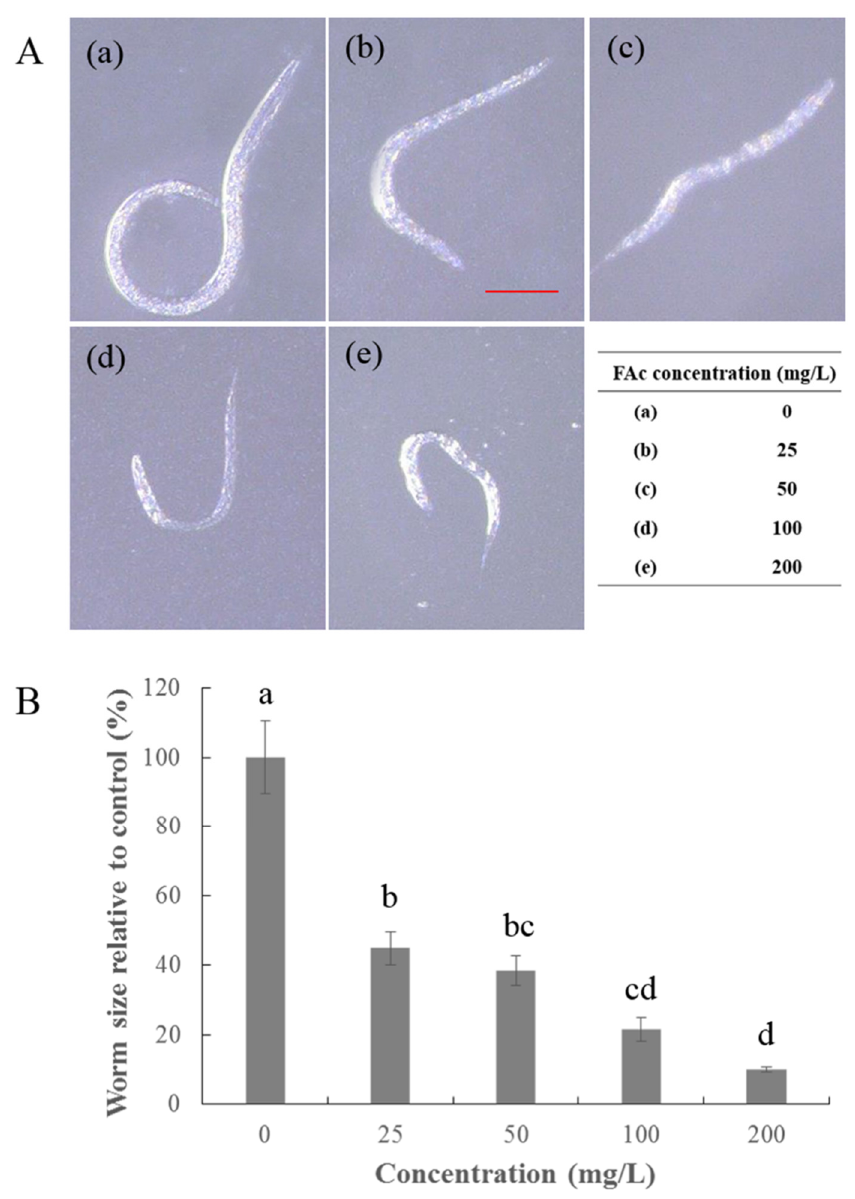
Figure 2. Growth assay of C. elegans treated with FAc. ( A ) ( a – e ) Wild-type L2 worms were cultured in gradient doses of FAc in a concentration range of 0–200 mg/L, incubated at 20 °C for 48 h, and photographed using a 3D digital microscope (Keyence VHX-6000, Keyence, Osaka, Japan). The scan bar is 100 μm. ( B ) The size of worms cultured in FAc as a percentage of the size of worms cultured in the distilled water (control). Data are shown as mean ± standard error ( n = 3), and different lowercase letters indicate significant difference among treatments by LSD test ( p < 0.05).